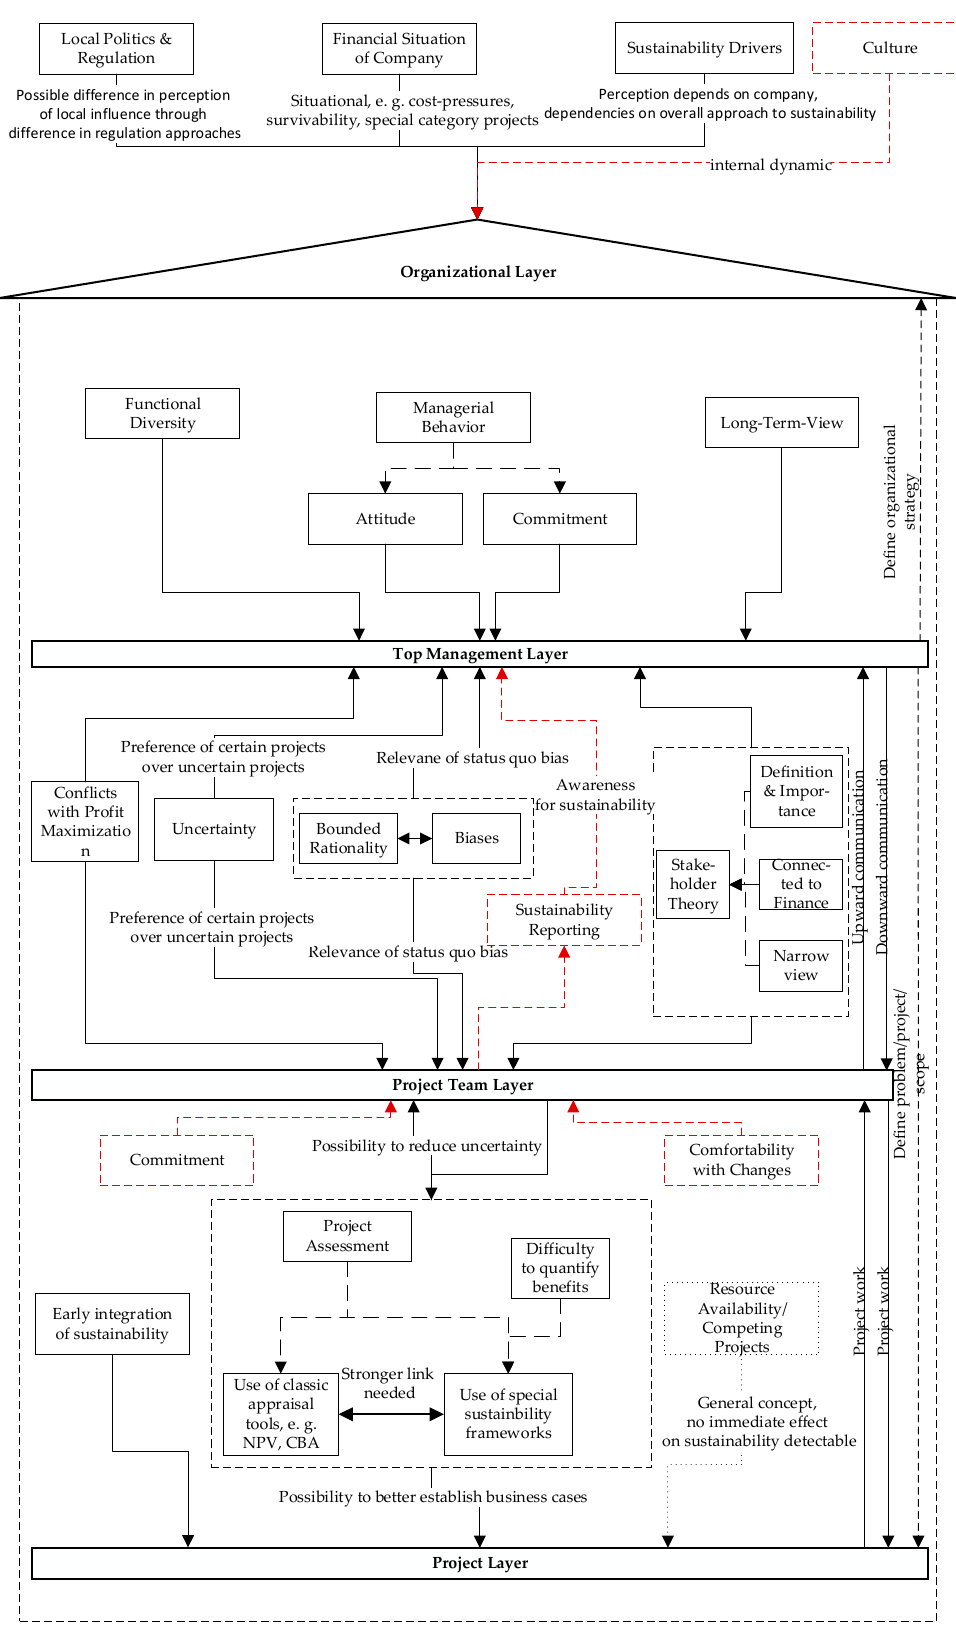
Figure 7. Adapted framework after integrating interview results and conclusions.